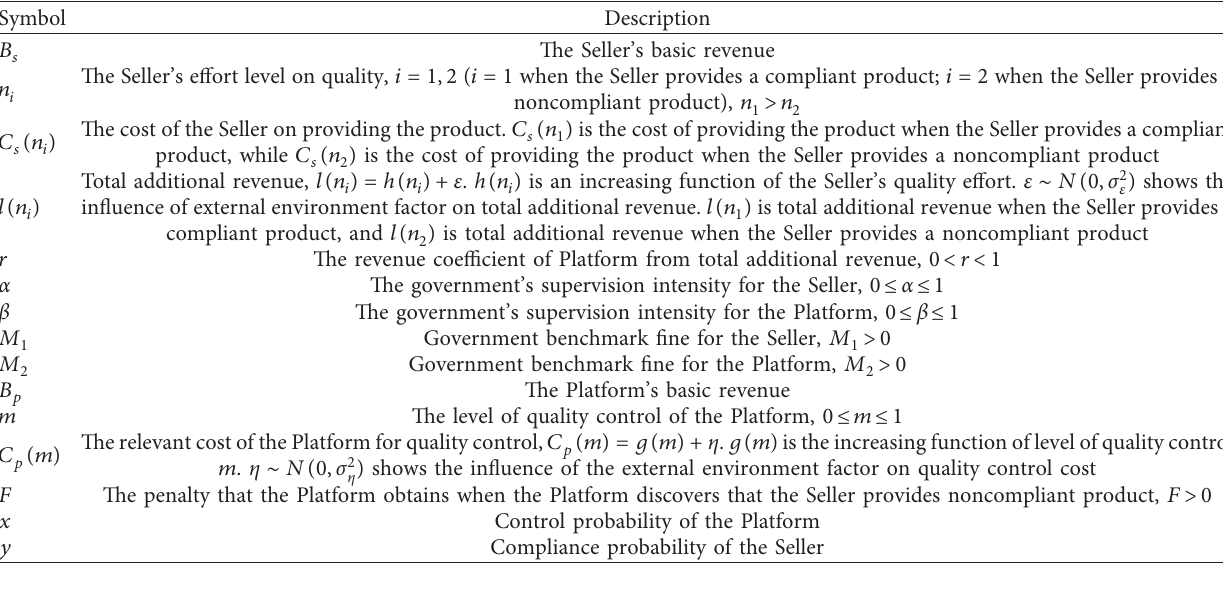
Table 1: Symbols and descriptions of parameters for Model I.